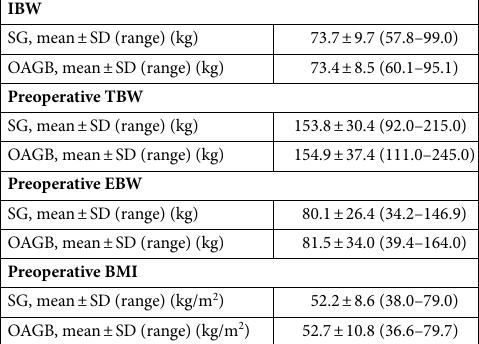
Table 2. Obese T2DM patient preoperative somatometric values. IBW ideal body weight, TBW total body weight, EBW excess body weight, BMI body mass index, SG sleeve gastrectomy, OAGB one anastomosis gastric bypass, SD standard deviation.